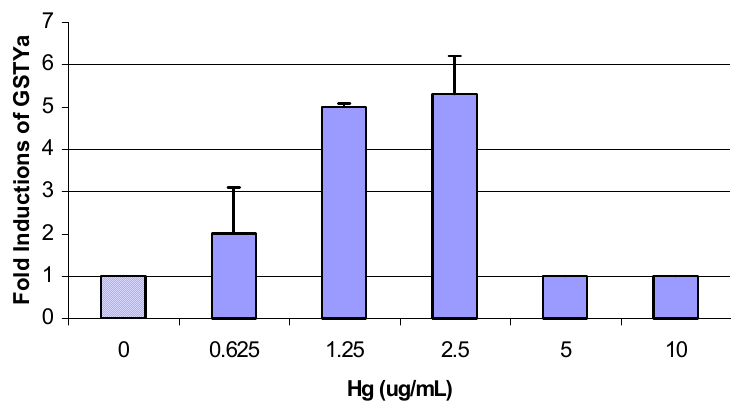
cells exposed to mercury for 48 hours. Data represent 2